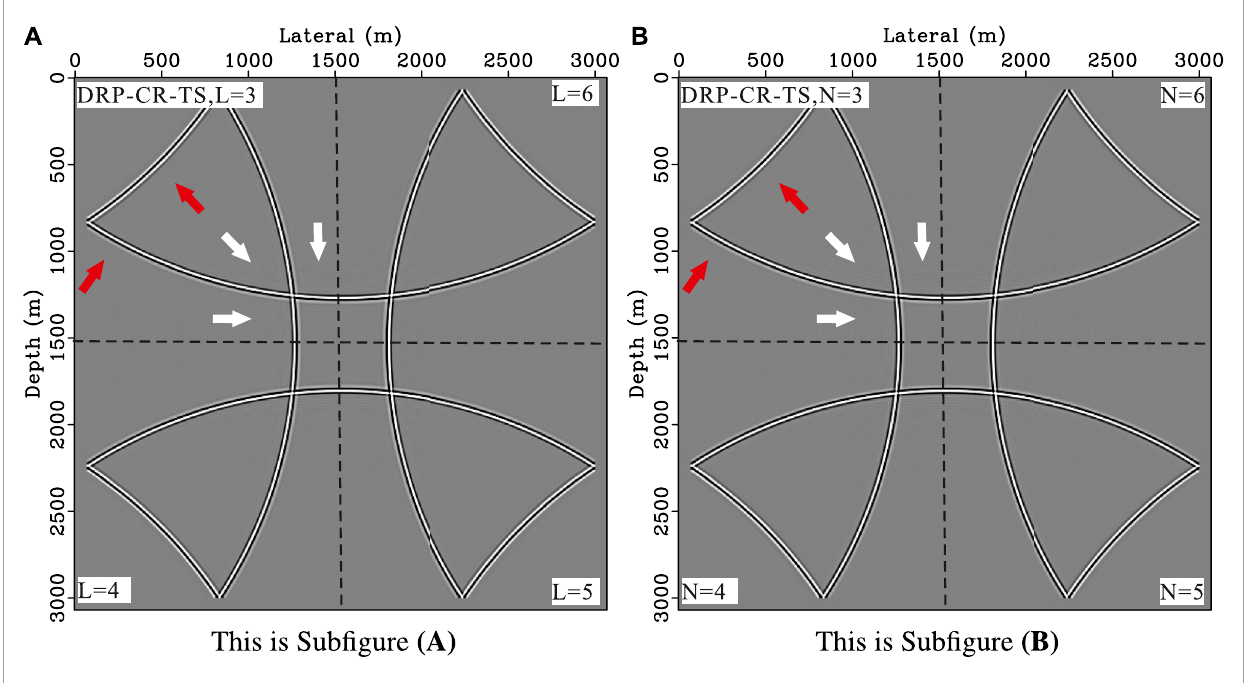
FIGURE 8 Snapshots of the simplified scheme for different L and N , where M = 8 , τ = 0.0015 s , υ = 1500 m / s and h = 6 m . The main frequency of the Ricker wavelet is 40 Hz . (A) DRP-CR-TS method with different L , here N = 3 . (B) DRP-CR-TS method with different N , here we set L = M .